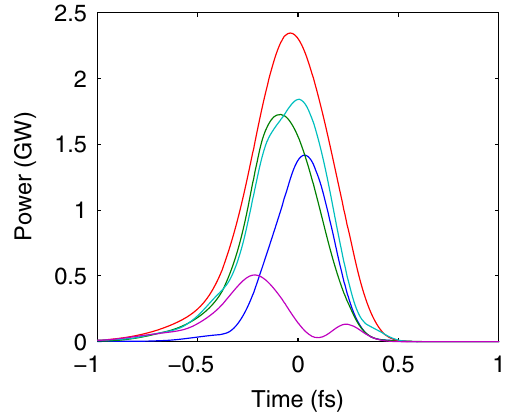
FIG. 12. Selection of FEL pulse temporal profiles at 17.7 m calculated using different shot-noise